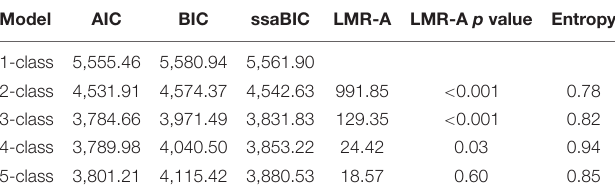
TABLE 2 | Fit of latent profile